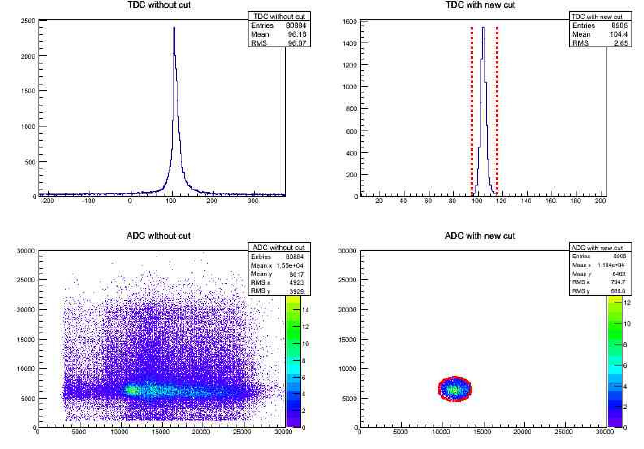
Figure 1. Selection of the dp -elastic events at about 75 ◦ in c.m.s. at 1000 MeV using time di ff erence and correlation of the energy-losses signals for proton and deuteron